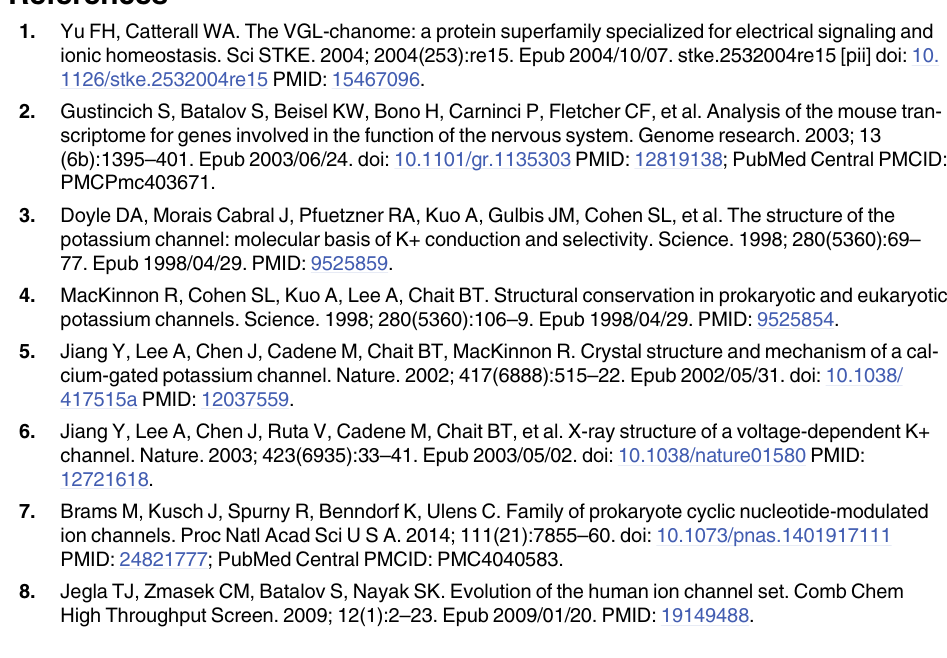
S1 Table. Sequences used in Fig 1